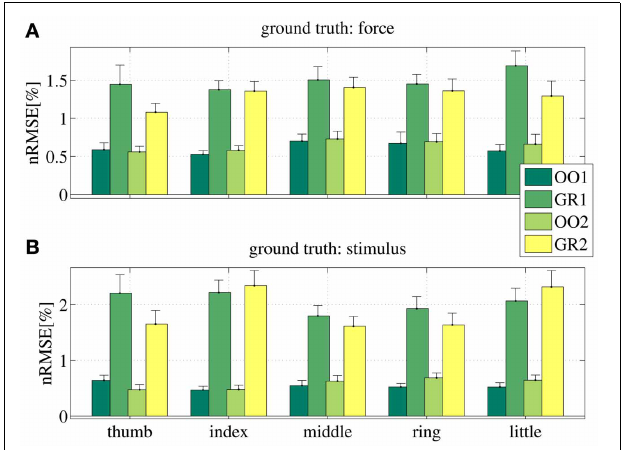
FIGURE 8 | Normalized root-mean-square error obtained by the linear prediction of force (A) and visual stimulus (B) for a typical subject, for each session (OO1, GR1, OO2 and GR2) and for each finger. Each bar and stem represents the mean nRMSE and one standard deviation obtained over the 50 cross-validation folds